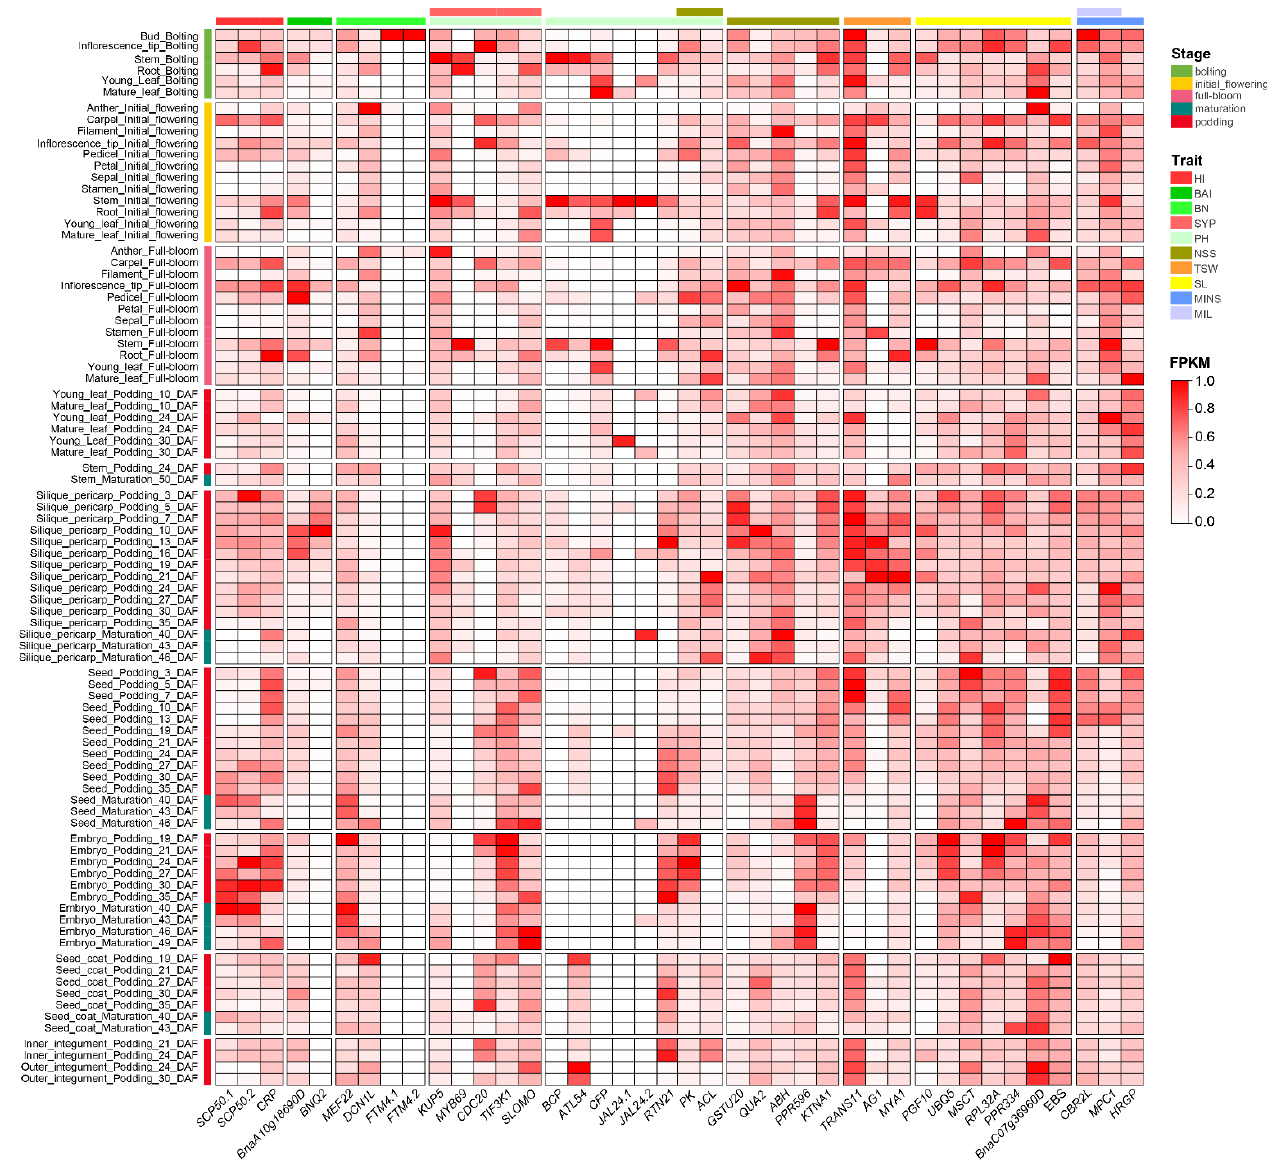
Figure 6. Heatmap of candidate gene expressions among different tissues. Each row indicates a tissue, and different colors represent different development stages and traits. More detailed information displayed in Table S4.